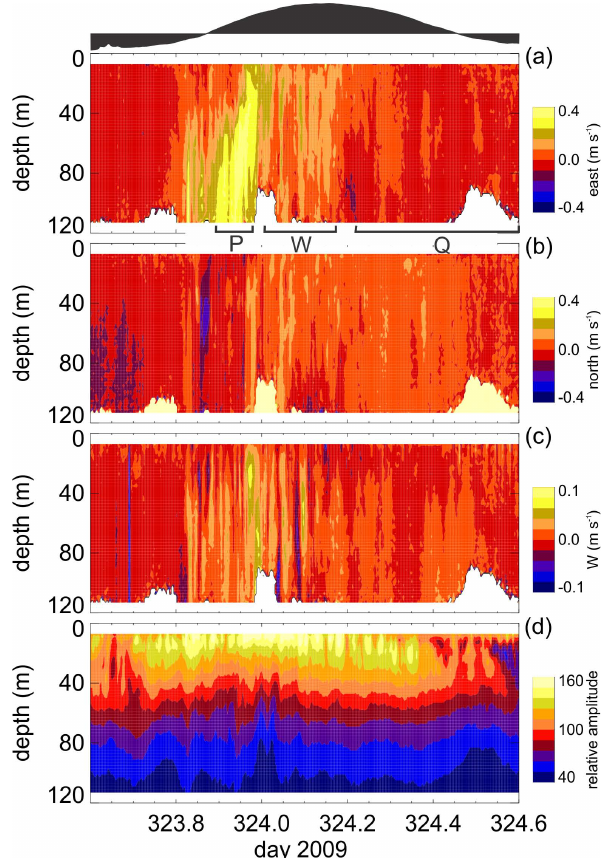
Fig. 6. ADCP data products. The ADCP resolved (a) east- ward velocity, (b) northward velocity, (c) upward velocity w , and (d) backscatter amplitude as a function of time (NZST = UTC+12). The approximate local depth range of the glacier is shown as hori- zontal dashed lines. The tidal elevation is shown not to scale above panel (a) . The blank sections at the base of panels (a) , (b) and (c) are where there was insufficient backscatter to calculate good quality velocities. The pulse (P), waves (W) and quiescent (Q) pe- riods are marked above (b)